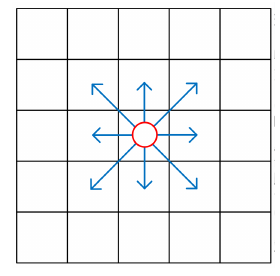
Figure 1. Restricted moving